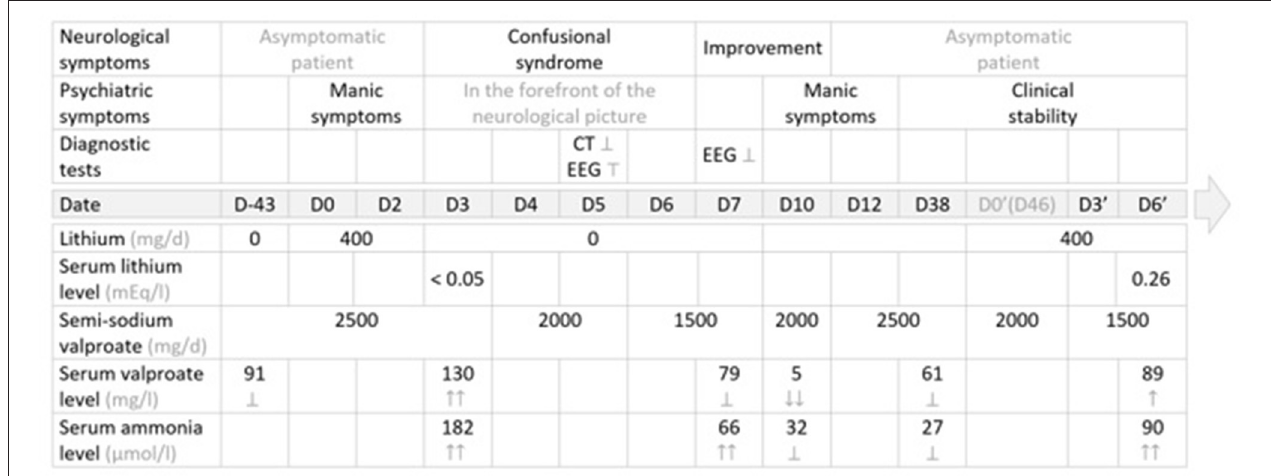
FIGURE 1 | Management summary: therapeutic strategy, clinical course and diagnostic tests. EEG, electroencephalogram; ER, extended release; NA, not administered; N, normal values → ; CT, computed tomography (brain) scan; T . , abnormal; ? , normal, within normal limits; ↑ , elevated value, within normal limits; ↑↑ , elevated value, above normal or supratherapeutic; ↓ , decreased value, within normal limits; ↓↓ , decreased value, below normal or subtherapeutic; l : discontinued; → Normal values: serum lithium level: N = (0.84–1.2) mg/l; serum valproate level: N = (41–100) mEg/l; serum ammonia level: N = (16–60) µ